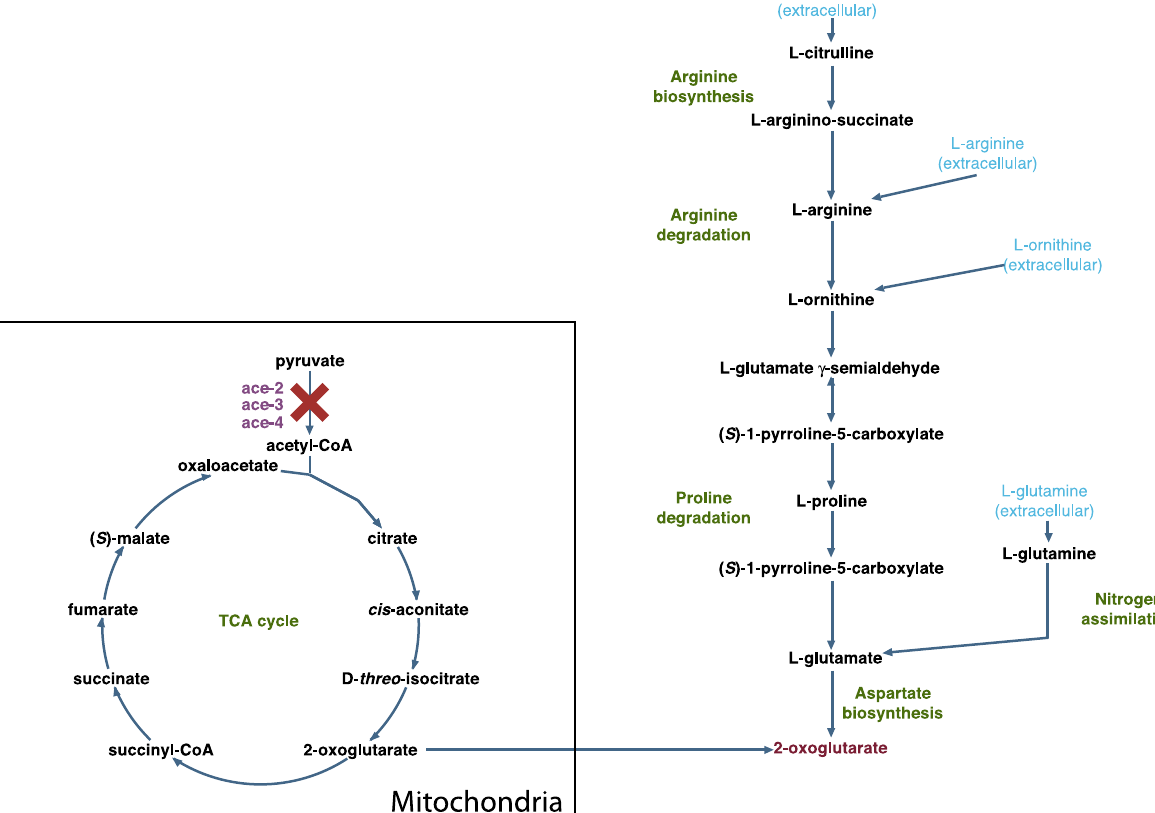
Figure 8. Supplementing with nutrients in alternate pathways can rescue some mutants. The model makes the novel prediction that ace- 2 , ace-3 , and ace-4 mutants (purple) in the TCA cycle can be rescued by supplementing minimal media with L-citrulline, L-arginine, L-ornithine, or L- glutamine (light blue) because each of these nutrients provide an alternate route via amino acid pathways to the essential metabolite 2-oxoglutarate (red).